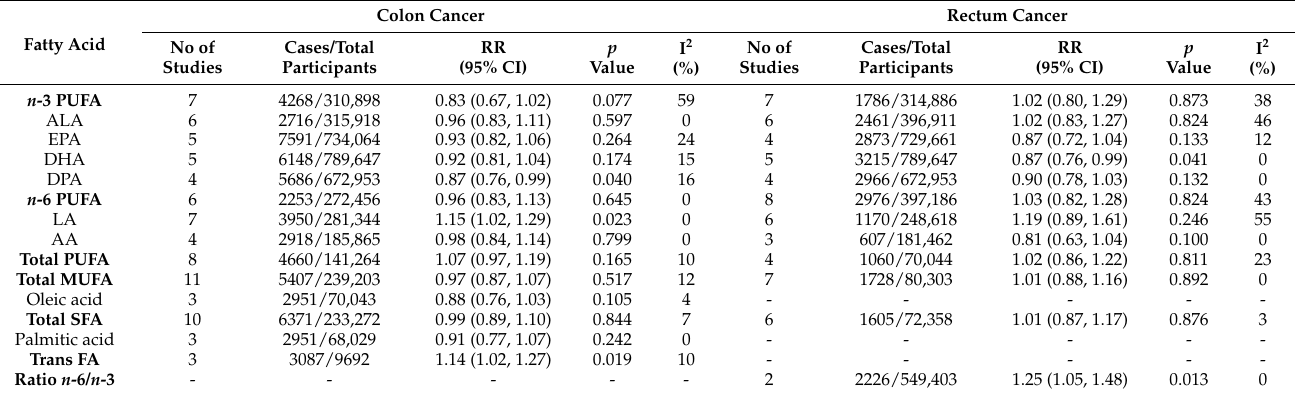
Figure 2. High versus low fatty acids intake and association with colorectal cancer risk. Estimates are odds ratio and meta-analyses are based on random effect models. SFA: saturated fatty acids; MUFA: monounsaturated fatty acids; PUFA: polyunsaturated fatty acids; HUFA: highly unsaturated fatty acids; trans-FA: trans-fatty acids; LC n -3 fatty acids: long-chain n -3 fatty acids. Table 1. Subgroup analysis of dietary fatty acids and risk of colon and rectal